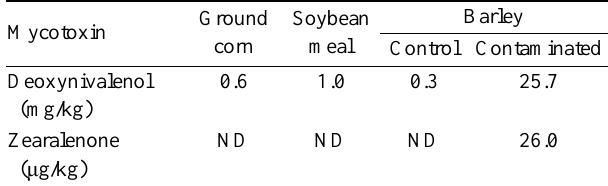
Table 1. Mycotoxin concentrations of ground corn, soybean